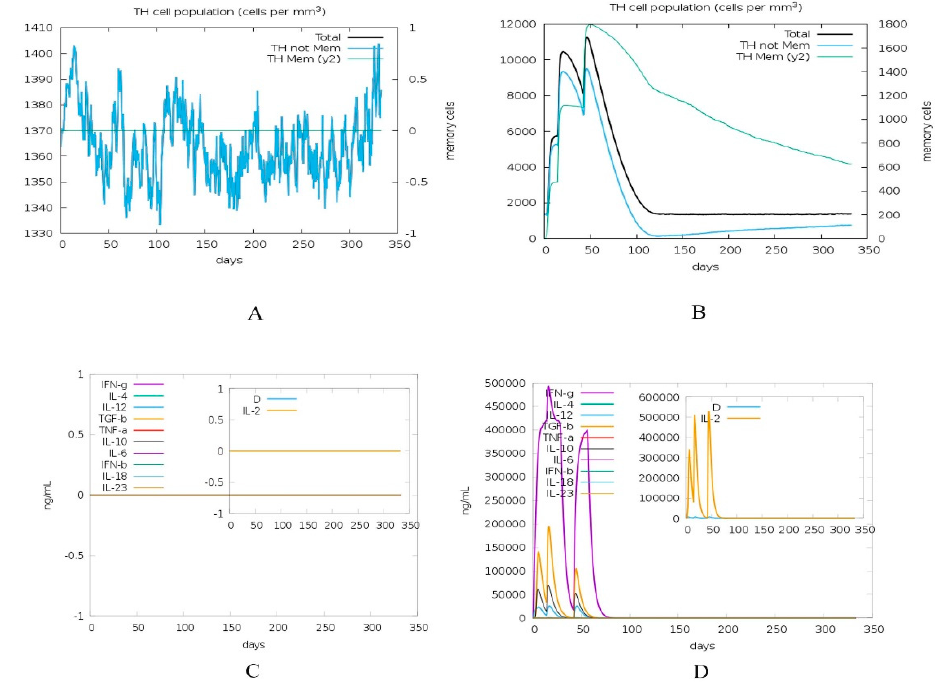
( B ) The plot shows total and memory counts of CD4 T-helper lymphocytes for construct C1. ( C ). The concentration of cytokines and interleukins for control with D in the inset plot representing danger signal. ( D ). The concentration of cytokines and interleukins for construct